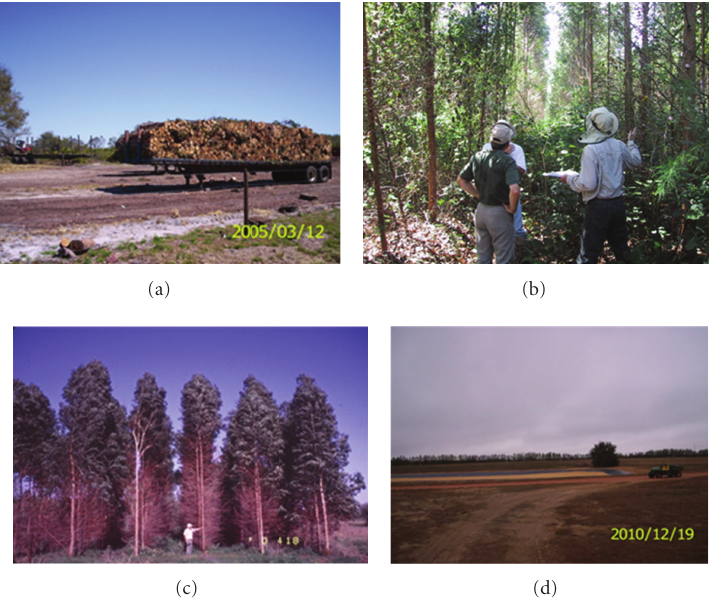
Figure 7: Uses of E. grandis in Florida—mulch wood (a), energy wood (b), dendroremediation (c), and windbreaks